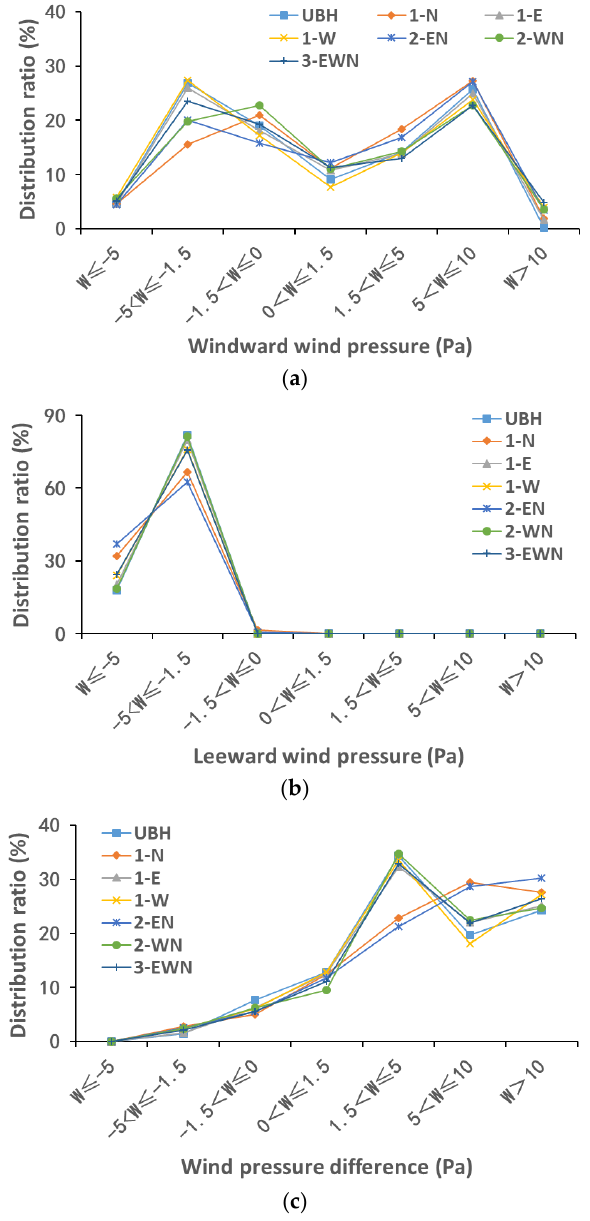
Figure 9. Proportional distribution of wind pressure for the seven building distribution patterns. ( a ) Windward pressure at the building, ( b ) leeward pressure at the building, and ( c ) wind pressure difference at the